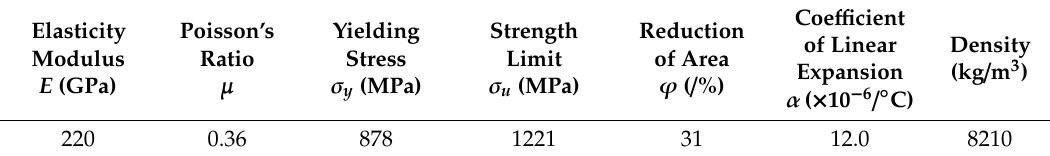
Table 2. The tensile properties of high pressure turbine disc.